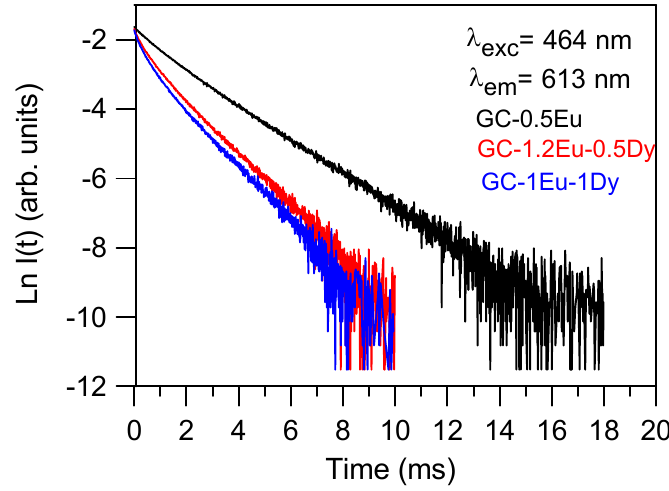
Figure 8. Experimental decays from level 5 D 0 (Eu 3+ ) obtained by exciting at 464 nm collecting the luminescence at the 5 D 0 → 7 F 2 emission (613 nm). Table 8. Experimental lifetimes from level 5 D 0 (Eu 3+ ) obtained by exciting at 464 nm collecting the luminescence at the 5 D 0 → 7 F 2 emission (613 nm).